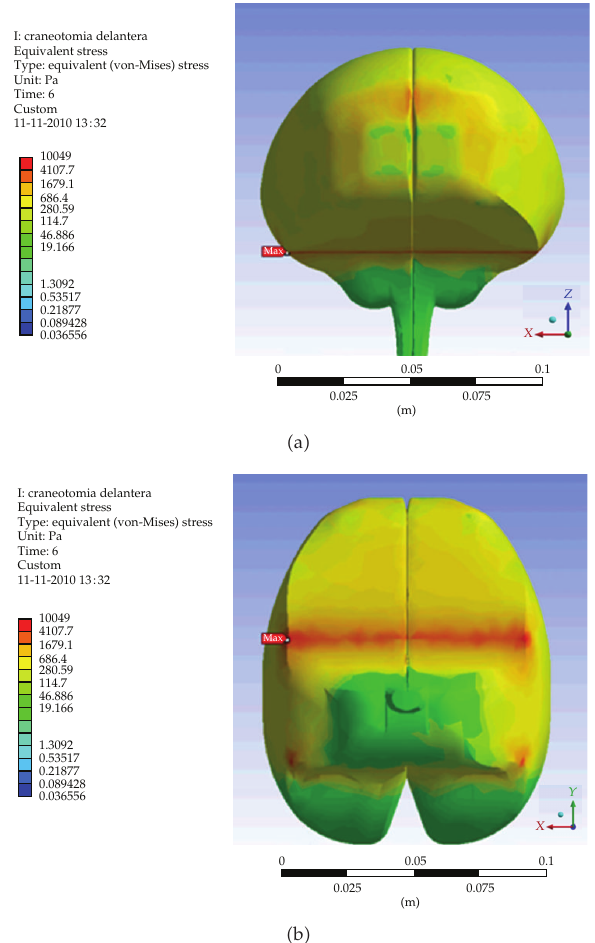
Figure 10: E ff ective stress for frontal craniotomy, hyperelastic second-order Ogden